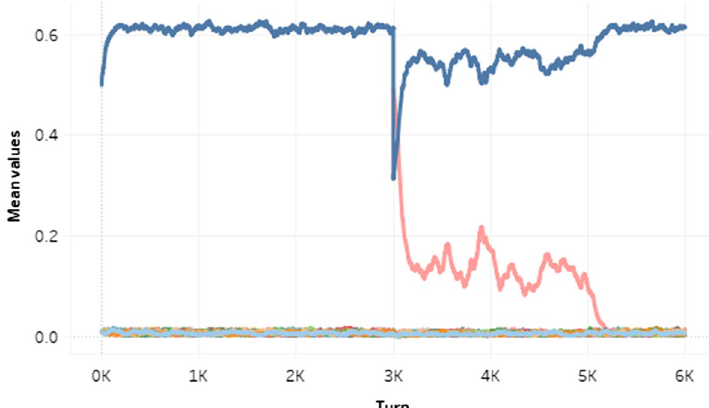
Fig. 5 Introduction of the cryptocurrency payments, case 1-A-2: Time series change of the mean of view. Blue line is the fiat money good, red line is the cryptocurrency good, and other colors represent remaining goods. Although the conditions are the same as those used in Fig. 4, the monetary function may ultimately be